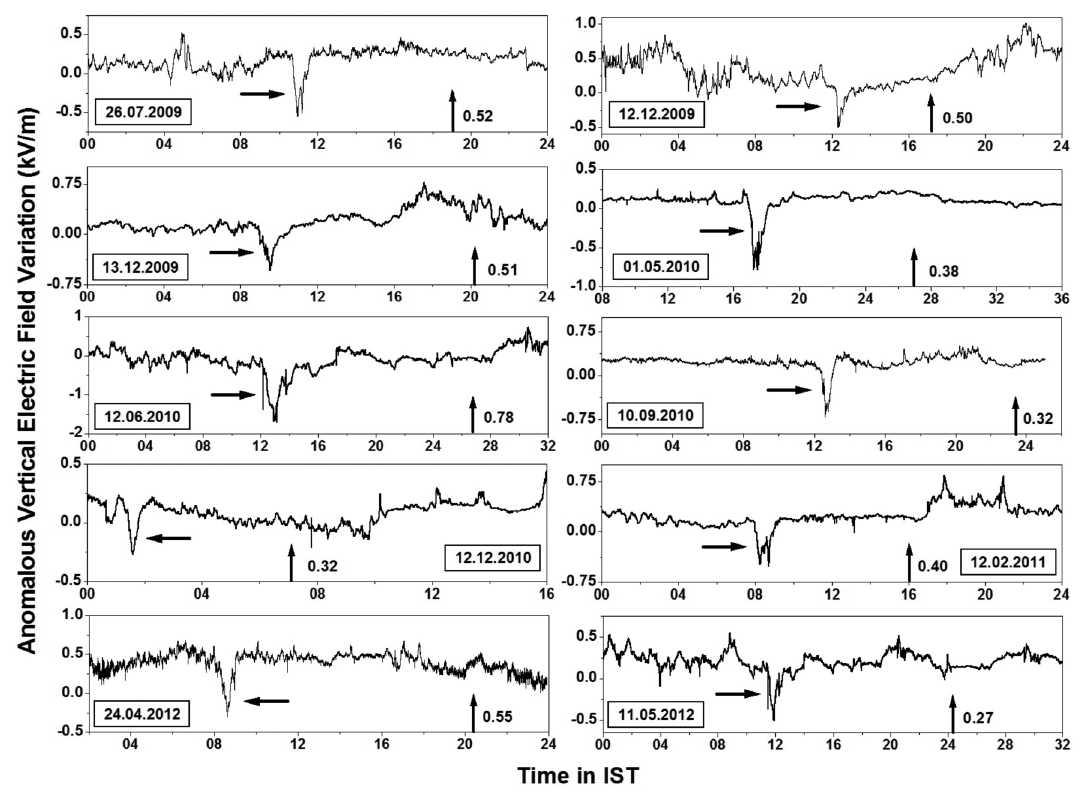
Figure 3. Diurnal variations in the VEF along with the earthquake for the 10 cases where a precursor was observed. Arrow to right/left, anomalous VEF variations; arrow up, time of strike of the earthquake plus ratio of earthquake magnitude to